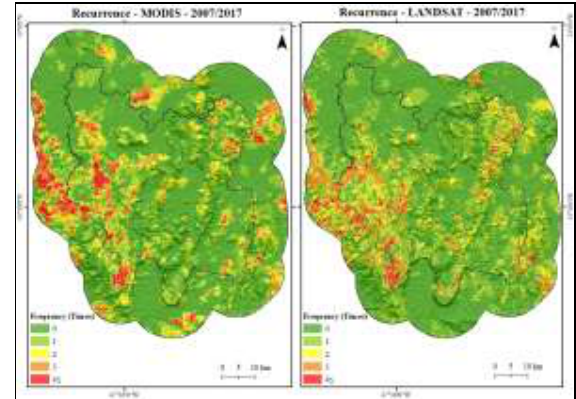
Figure 2. Comparison between MODIS and LANDSAT recurrences originate from burn scars